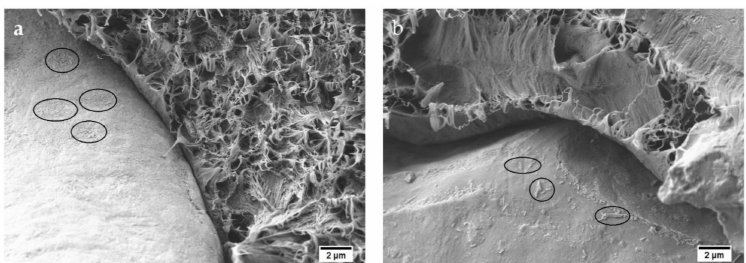
Figure 4. Field emission scanning electron microscopy (FESEM) images at 5000 × of the fractured surfaces of samples compatibilized with HNTs: ( a ) Bio-HDPE/PE-g-MA/MAS/HNTs (7.5 phr HNTs); ( b ) Bio-HDPE/PE-g-MA/MAS/HNTs/MLO (3.75 phr